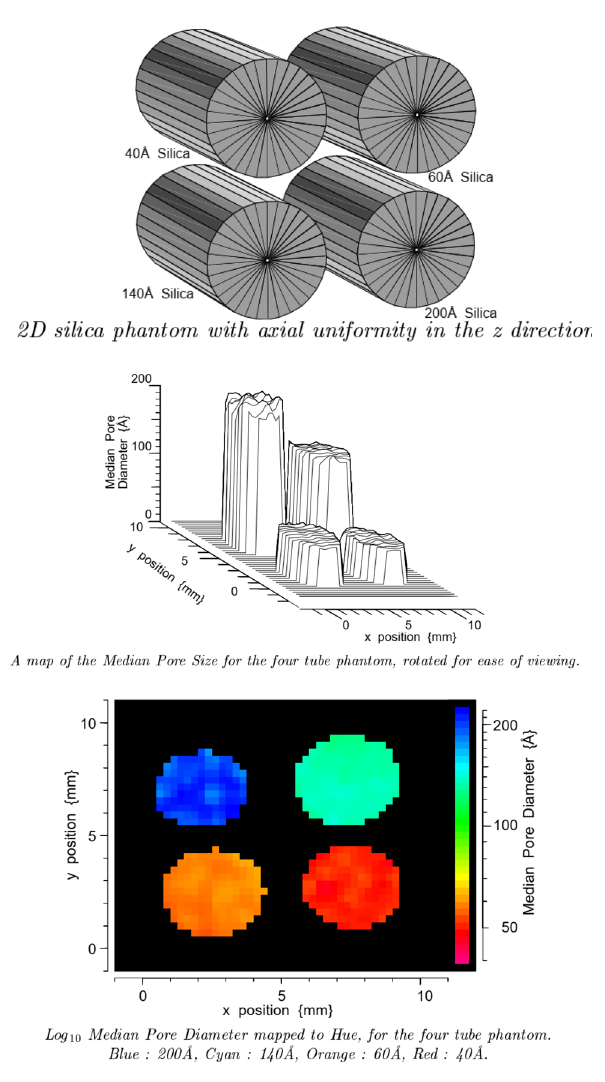
Fig. 27 2 D spatially resolved pore sizes—4 different sol-gel silicas in a set of 5mm diameter NMR